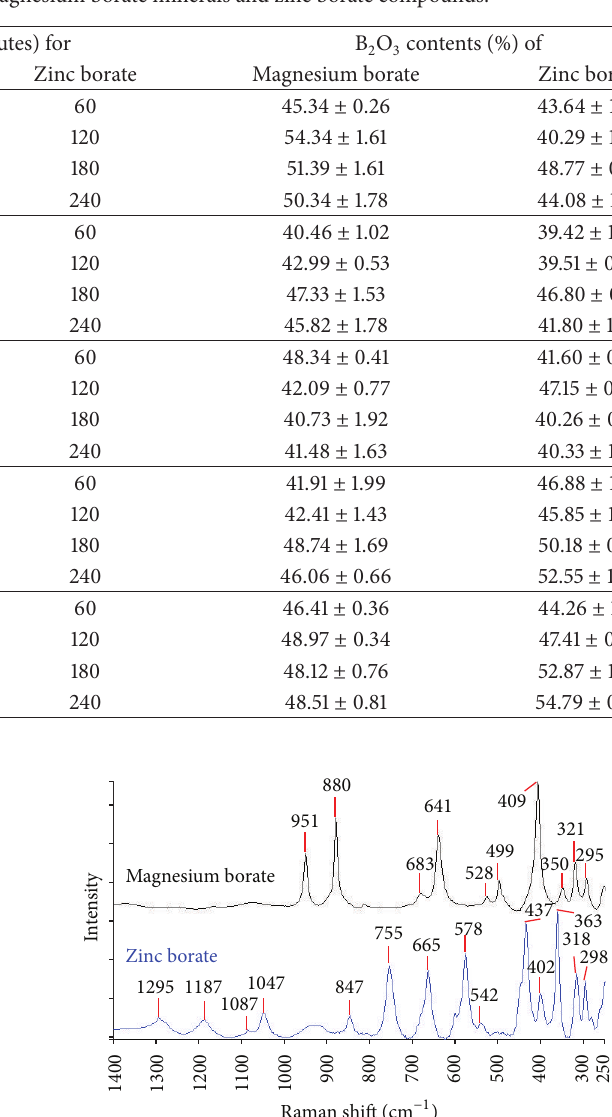
Table 5: B O contents (%) of the synthesised magnesium borate minerals and zinc borate compounds. 2 3